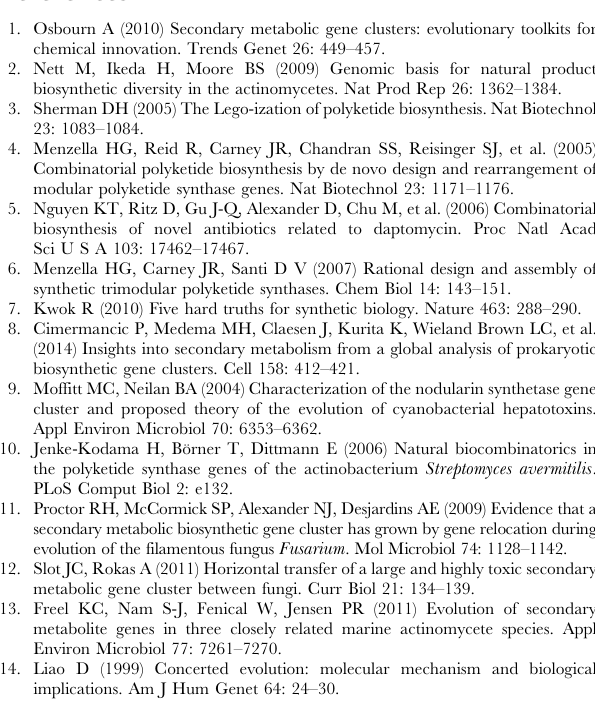
Table S2 Results from the phylogenetic profiling anal- ysis at three different cross-correlation cutoffs. The first and second column of each table show a number of co-evolving and non-coevolving motifs, followed by p-values from a Chi 2 -test (in which the first two numbers were assumed to be equally distributed), a string of Pfam IDs that constitute a motif, and their description. Table S3 Sub-cluster type-specific cut-offs to determine sub-cluster sharing between BGCs. Suitable cut-offs were determined by a manual comparison of known sub-clusters to their corresponding known chemical moieties, and cut-offs were set at those sequence identities where the chemistry produced by the enzymes encoded by the sub-clusters was (nearly) identical. (XLSX) Data S1 Python script and associated data files that were used to identify insertions/deletions, duplications and rearrangements in homologous gene